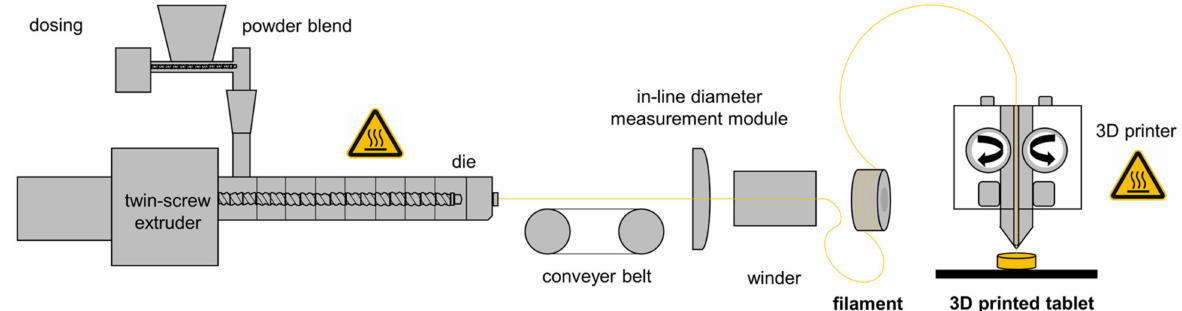
Figure 1. Illustration of the two heat-intensive processes for the manufacturing of 3D printed tablets by HME and FDM (modified from